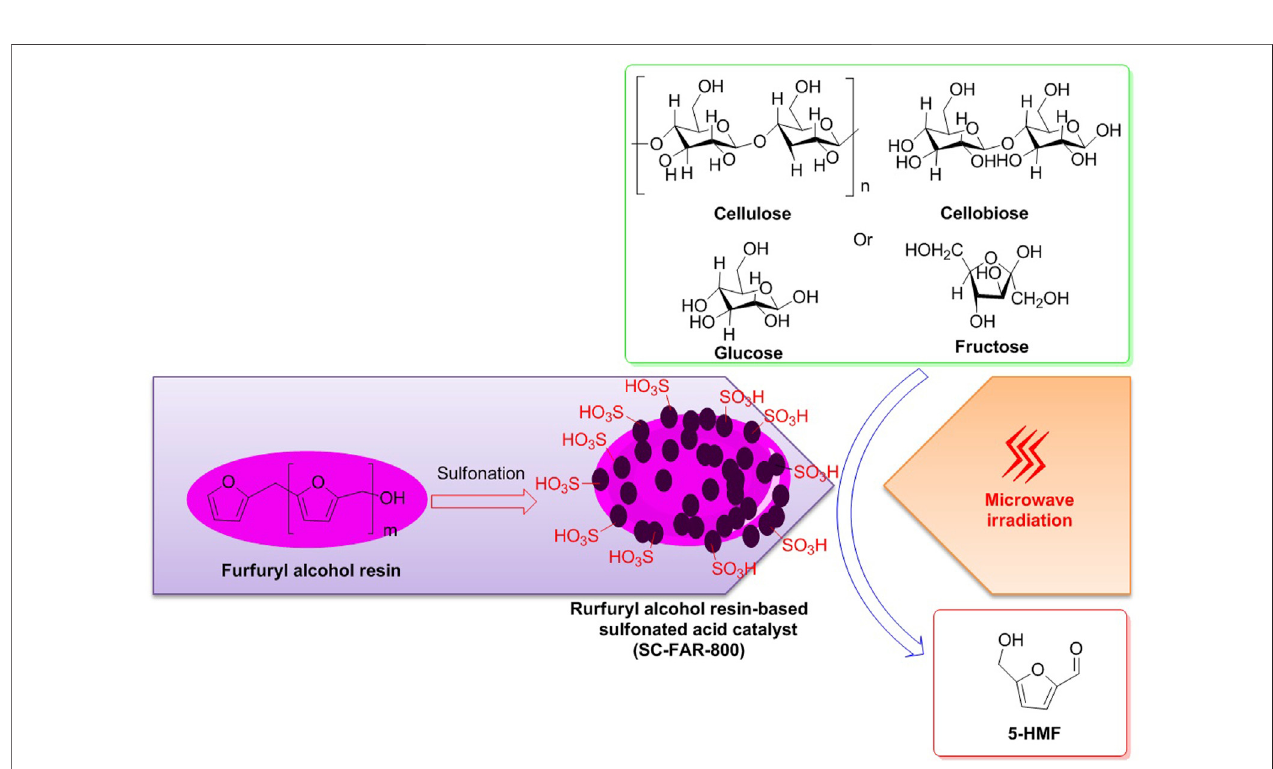
Frontiers in Chemistry |